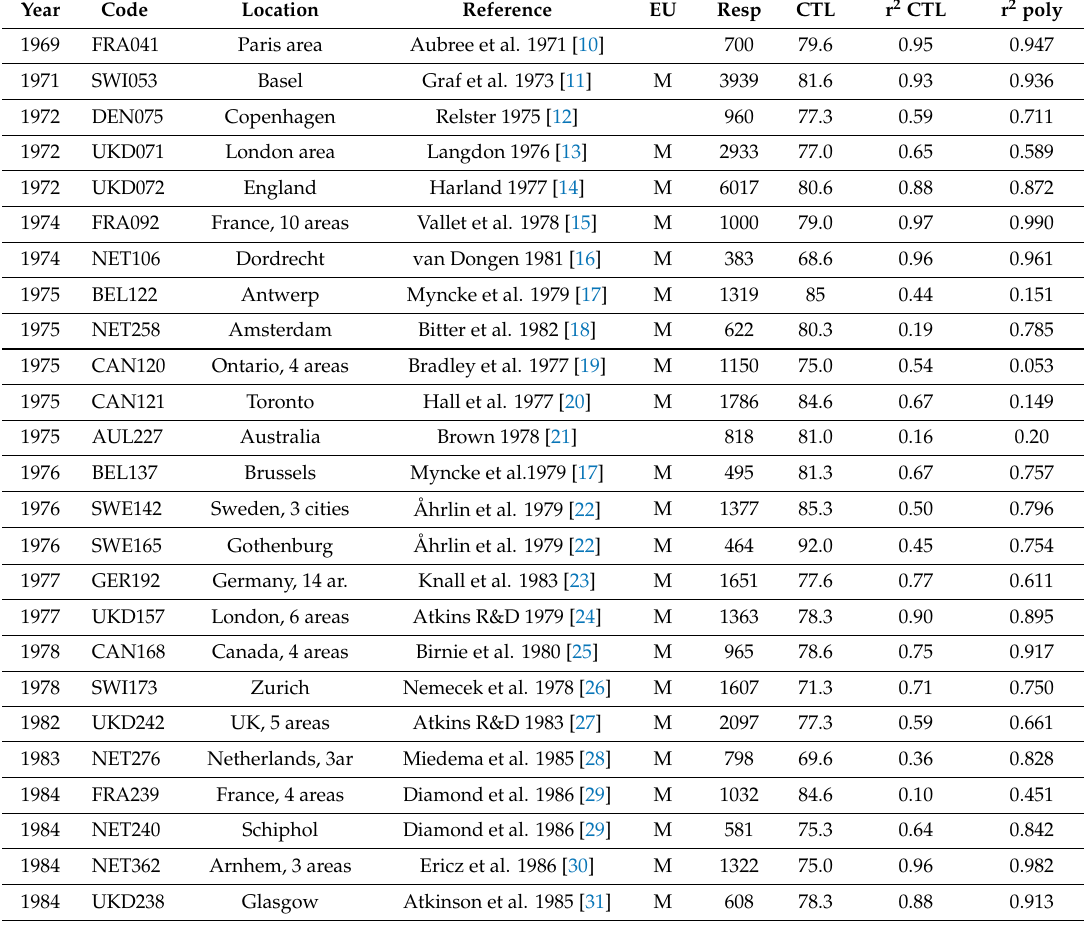
Table 1. Annoyance surveys included in the current